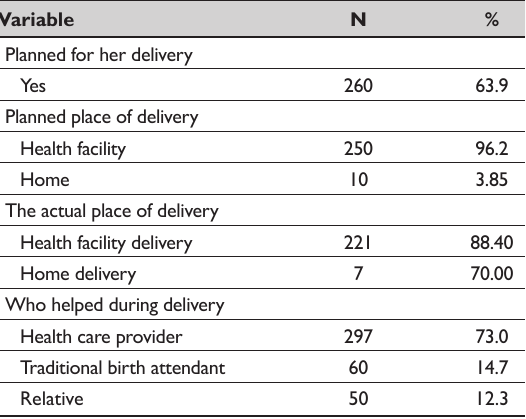
Table 1: Percentage of women aged 15-24 with a live birth in the 2 years preceding the survey who planned for a place of delivery and their final place